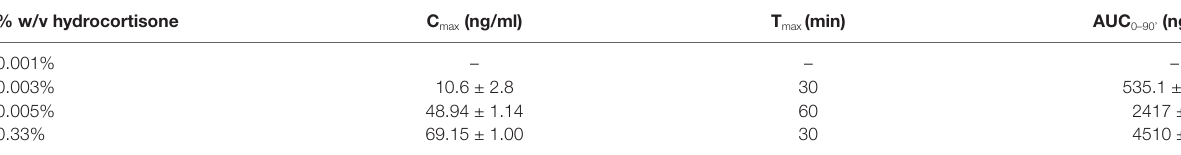
TABLE 1 | Aqueous distribution of hydrocortisone after instillation of four formulations in the rabbit eye: PK parameters. % w/v hydrocortisone